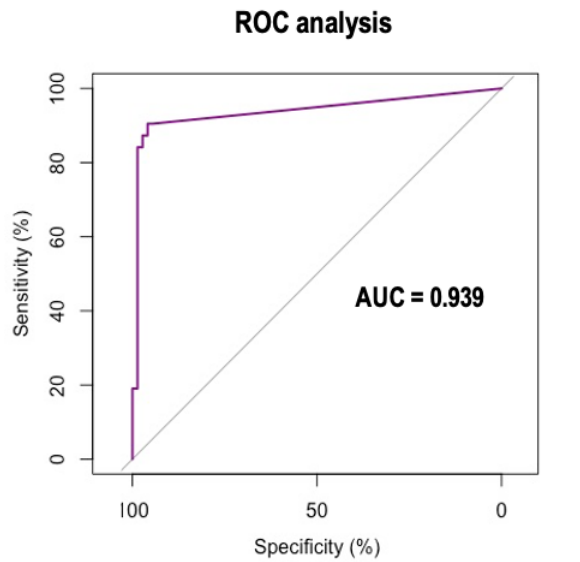
Figure 6. ROC analysis to obtain the best threshold (2%) to predict whether a smear belongs to the COVID-19 RL-positive group or